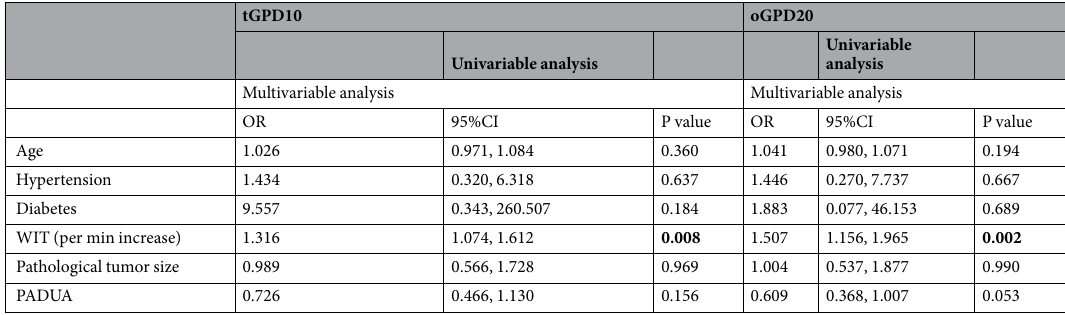
Table 4. Univariable and multivariable logistic regression for perioperative factors associated with postoperative tGPD10 and oGPD20 in validation